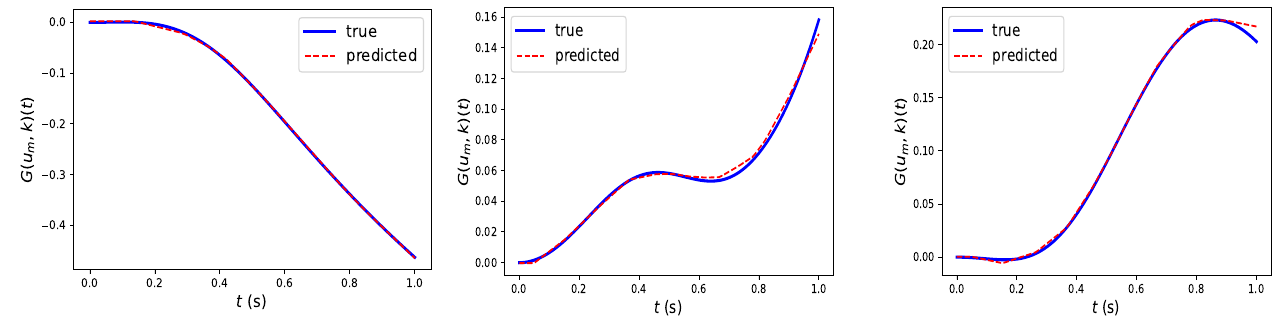
Figure 7. Fed-DeepONet G θ ∗ prediction of three solution trajectories driven by three inputs generated using a Gaussian Random Field but not included in the training dataset, and the parameter k sampled uniformly within the interval [ 0.5,1.5 ] . The computed L 2 -relative errors are: ( left ) e L = 1.252%, and ( right ) e = 1.561%. ( middle ) e L L 2 2